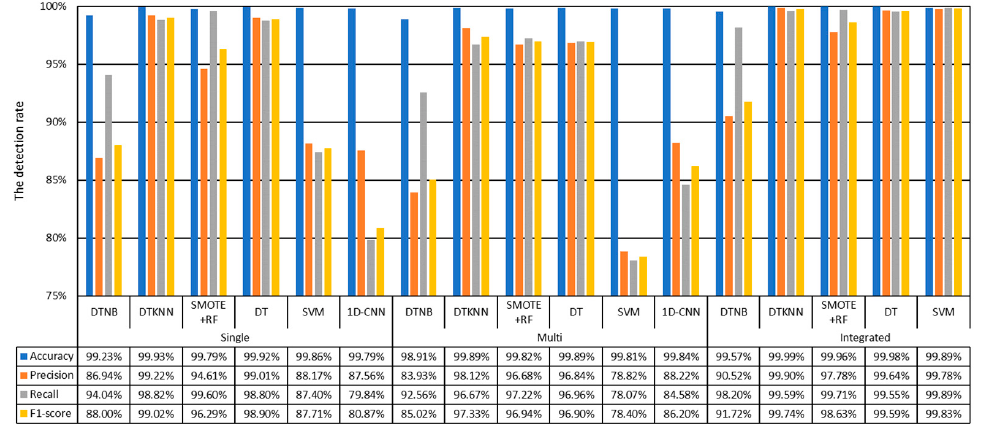
Figure 7. Performance metrics for machine learning models, according to each feature set.